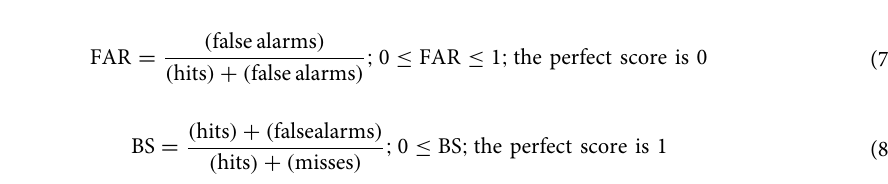
Figure 3. (a) Observed TC peak surges (ξ) versus SSHPI (Eq. 4) as a function of intensity, size, forward speed, and bathymetry. Dashed line shows the correlation gradient of the respective surge (ξ) and SSHPI; (b) Scatter plot of estimated (Eq. 5) and observed peak storm surge heights at selected